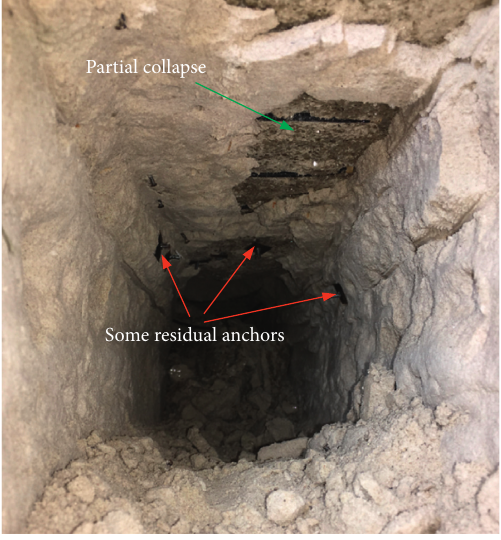
Figure 11: Roadway morphology after excavation in the experiments.